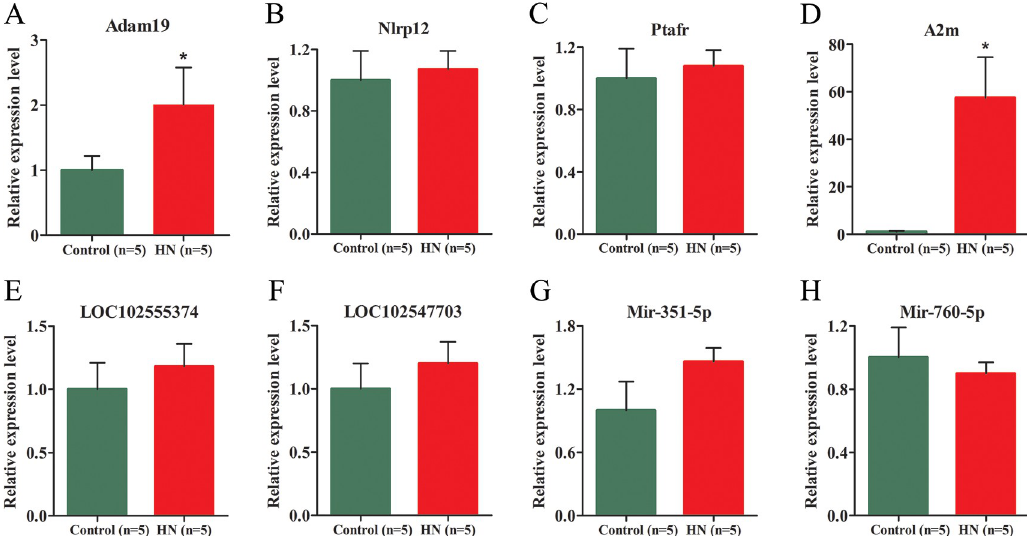
Fig 9. qRT-PCR validation of representative mRNAs, lncRNAs and miRNAs. The relative expression levels of mRNAs (A-D), lncRNAs (E, F) and miRNAs (G, H) were validated in kidney samples from HN rats (n = 5) and control rats by qRT-PCR for comparison to the RNA-seq results. For the comparison of quantitative data between groups, Student’s t-test was used. Differences in means were considered statistically significant at � P < 0.05.